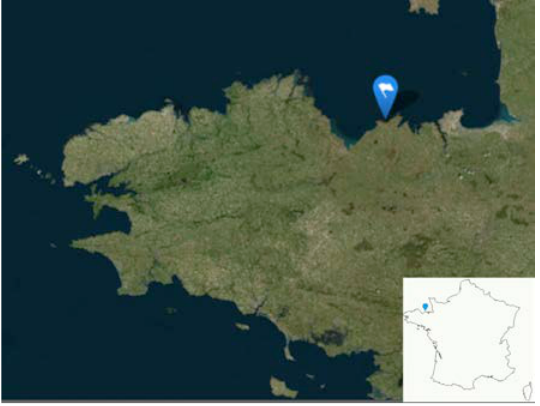
Figure 1. Erquy Les Hôpitaux, wreck